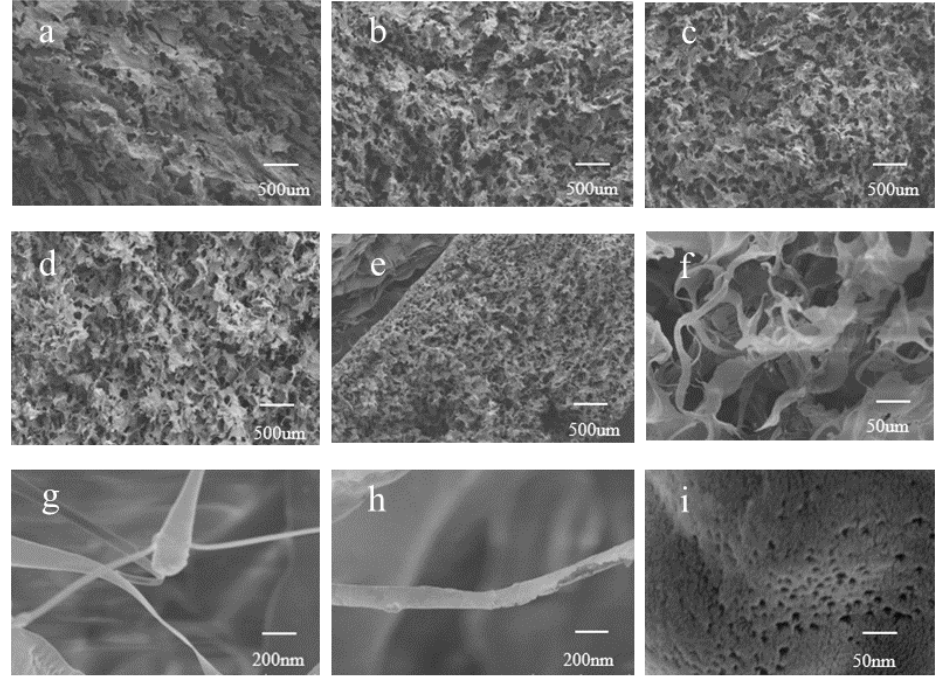
Figure 3. The image of KPP NFCs and the FESEM images of ( a ) KPPA0, ( b ) KPPA1, ( c ) KPPA2, ( d ) KPPA3, ( e ) KPPA4, ( f – h ) fibers of KPPA4 and ( i ) the pore structure of KPPA4.